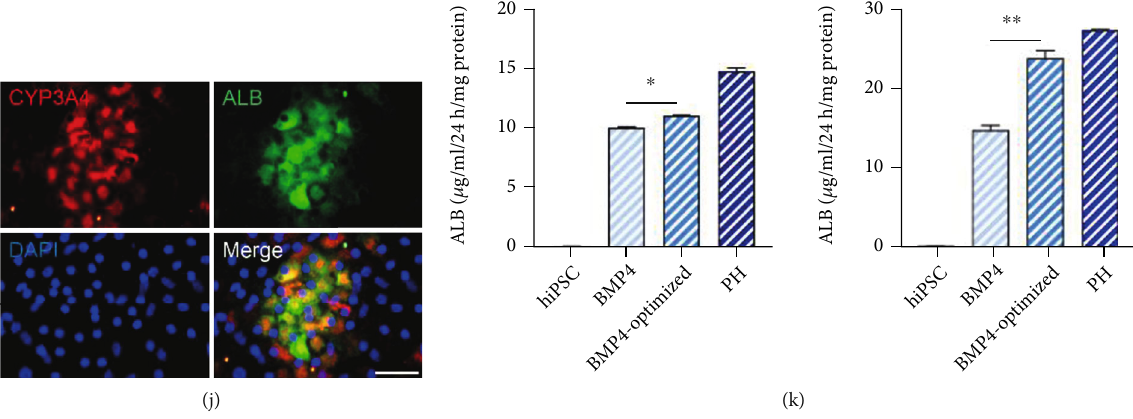
Figure 5: Optimization of the BMP4 di ff erentiation protocol signi fi cantly promotes hepatocyte function. (a) q-PCR analysis showed the expression levels of mature hepatocyte markers. ∗ p < 0 : 05 , ∗∗ p < 0 : 01 , ∗∗∗ p < 0 : 001 , and n = 3 . (b – d) Immuno fl uorescence showed that the cells coexpressed hepatocyte markers induced by BMP4 or BMP4-optimized protocols. Scale bars, 50 μ m. ∗ p < 0 : 05 , ∗∗ p < 0 : 01 , ∗∗∗ p < 0 : 001 , and n = 3 . (e, f) Hepatocytes performed PAS (top), ORO (middle), and ICG (bottom). Scale bars, 50 μ m. ∗ p < 0 : 05 , ∗∗ p < 0 : 01 , ∗∗∗ p < 0 : 001 , and n = 3 . (g, h) Phase-contrast images of senescence β -Gal staining in hepatocytes during days 30-60 induced by original or BMP4-optimized medium. Scale bars, 25 μ m. ∗ p < 0 : 05 , ∗∗ p < 0 : 01 , ∗∗∗ p < 0 : 001 , and n = 3 . (i) ORO staining treated by BMP4 optimized medium in day 65. Scale bars, 50 μ m. (j) Immuno fl uorescence showed that hepatocytes coexpressed ALB and CYP3A4 in day 65. Scale bars, 25 μ m. (k) Production of ALB and AAT in day 35 hepatocytes. Primary hepatocytes were used as positive controls; hiPSCs were used as negative control. ∗ p < 0 : 05 , ∗∗ p < 0 : 01 , ∗∗∗ p < 0 : 001 , and n = 3